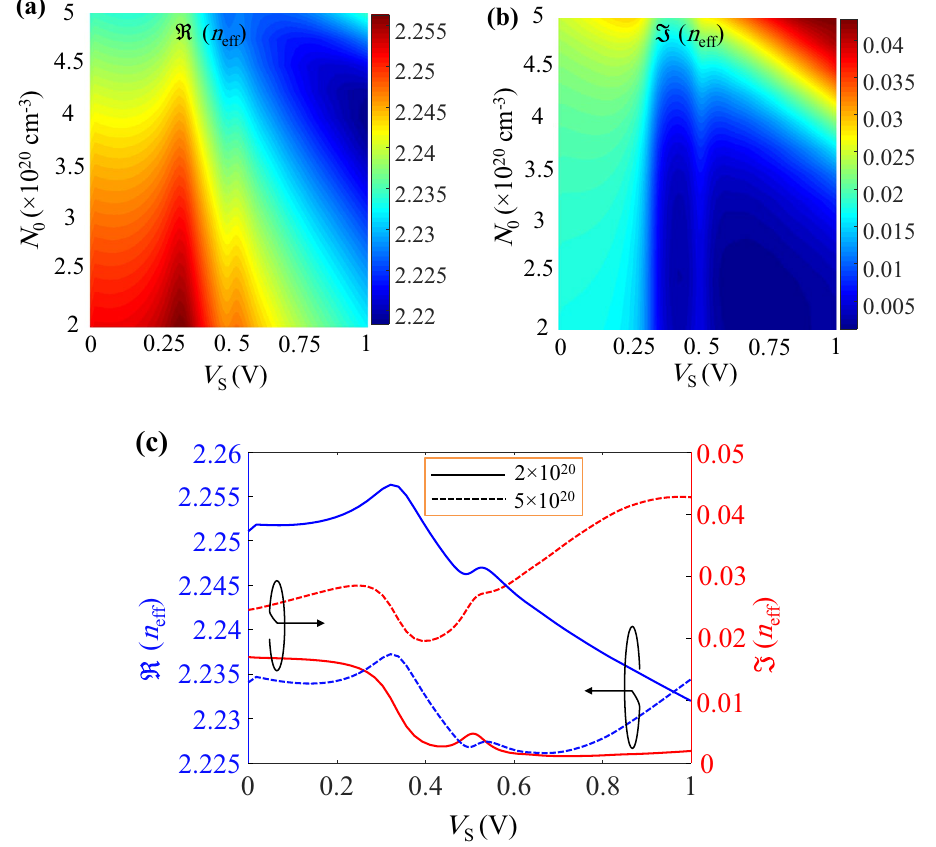
( n eff ) and ( b ) ( n eff ) of the proposed waveguide as functions of ITO Figure 3. Color plots of ( a ) ℜ ℑ ( n eff ) and ( n eff ) at lower and upper bounds of N 0 (i.e. doping and the external voltage. ( c ) Variations of ℜ ℑ N 20 cm 3 and 5 10 20 cm − 3 ). 0 = 2 × 10 − ×